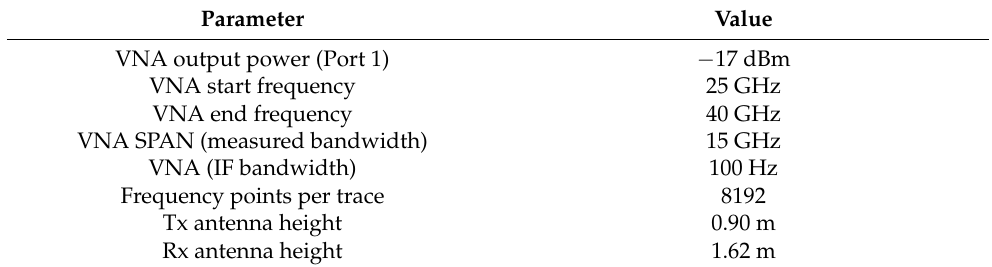
Table 1. Channel sounder parameters and configuration used in the channel measurements.